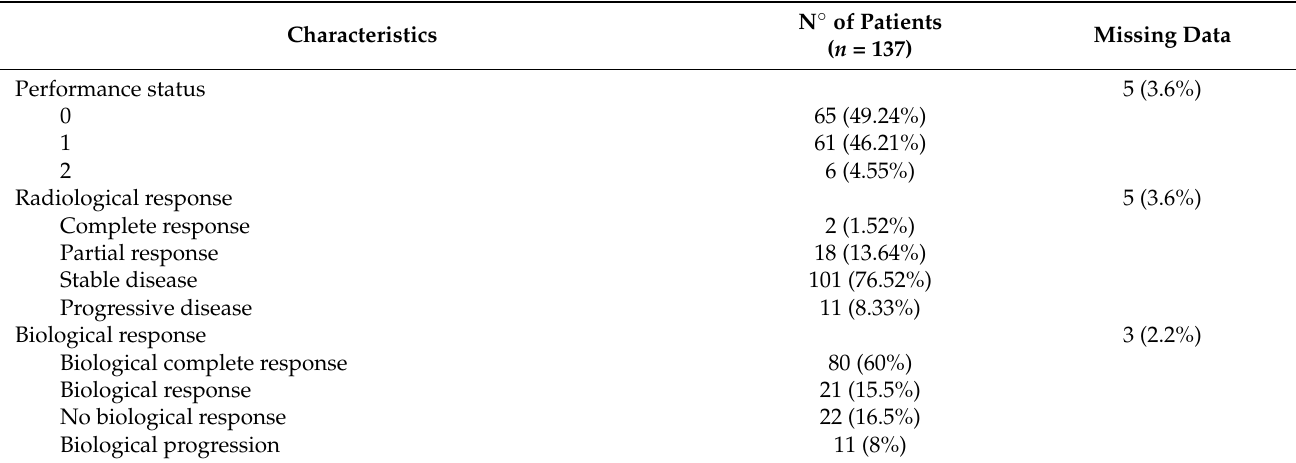
Table keys: the radiological response was evaluated according to the RECIST1.1 criteria. The biological response was defined as a decrease of ≥ 50% in the PSA concentration at